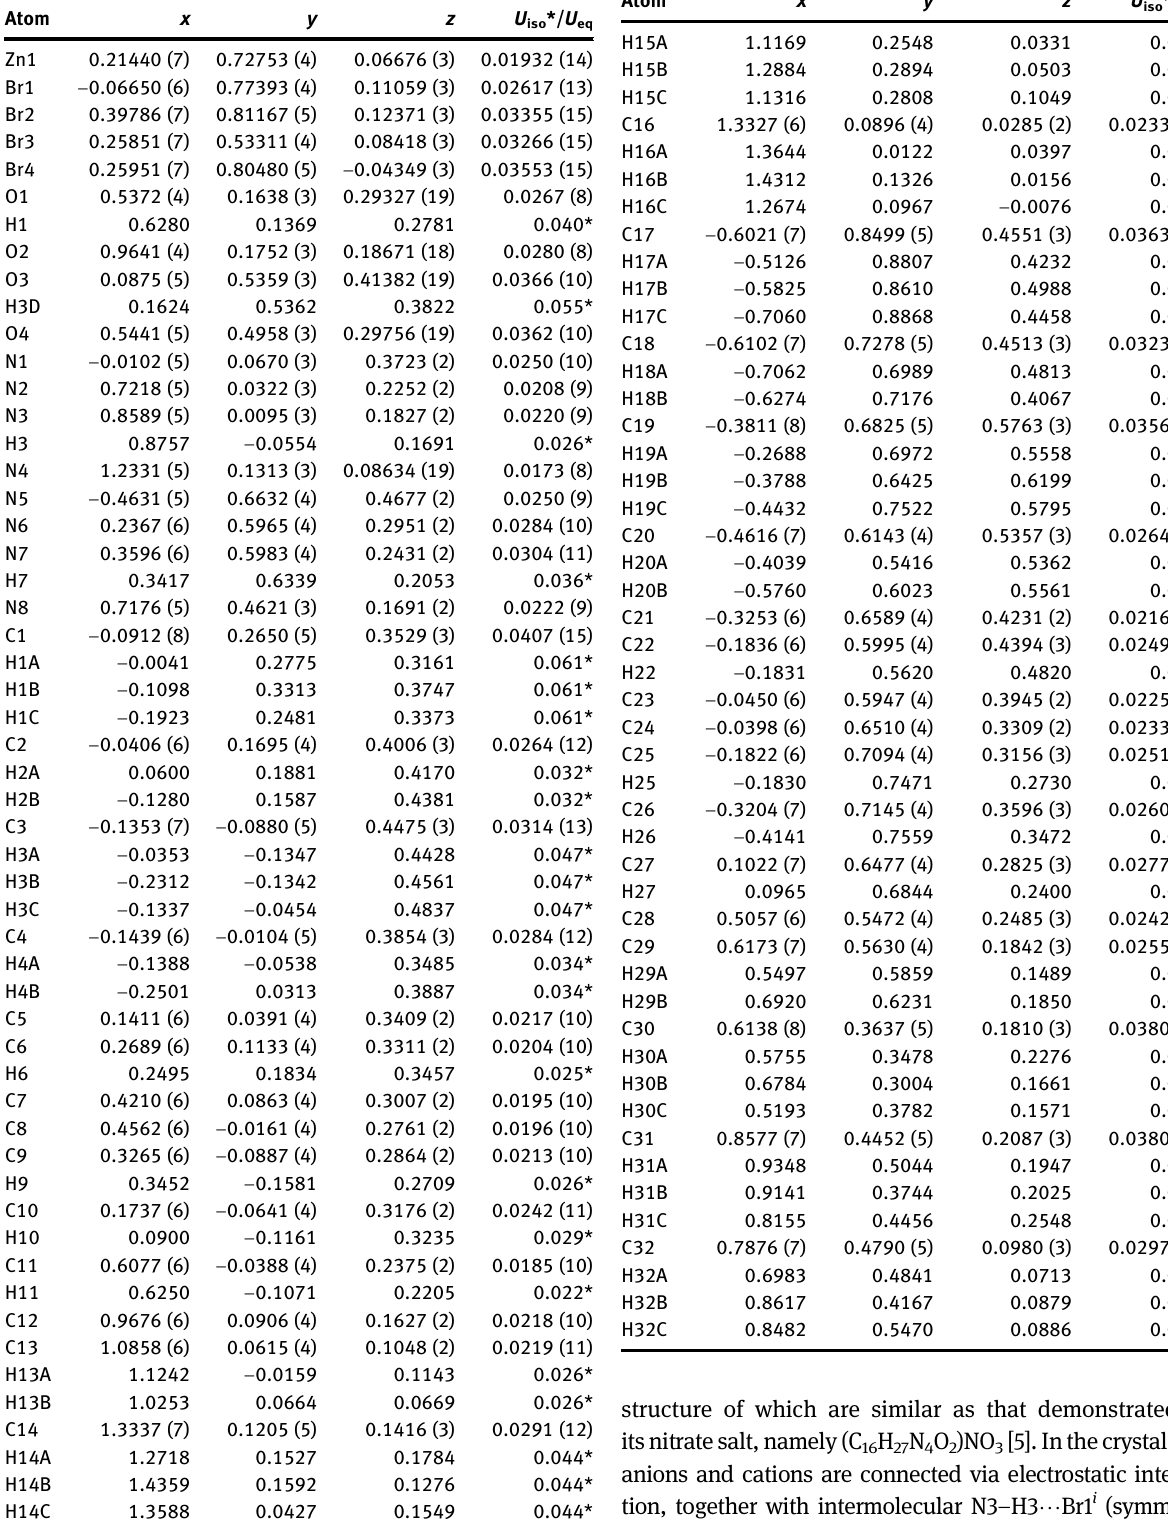
Table  : Fractional atomic coordinates and isotropic or equivalent isotropic displacement parameters (Å 